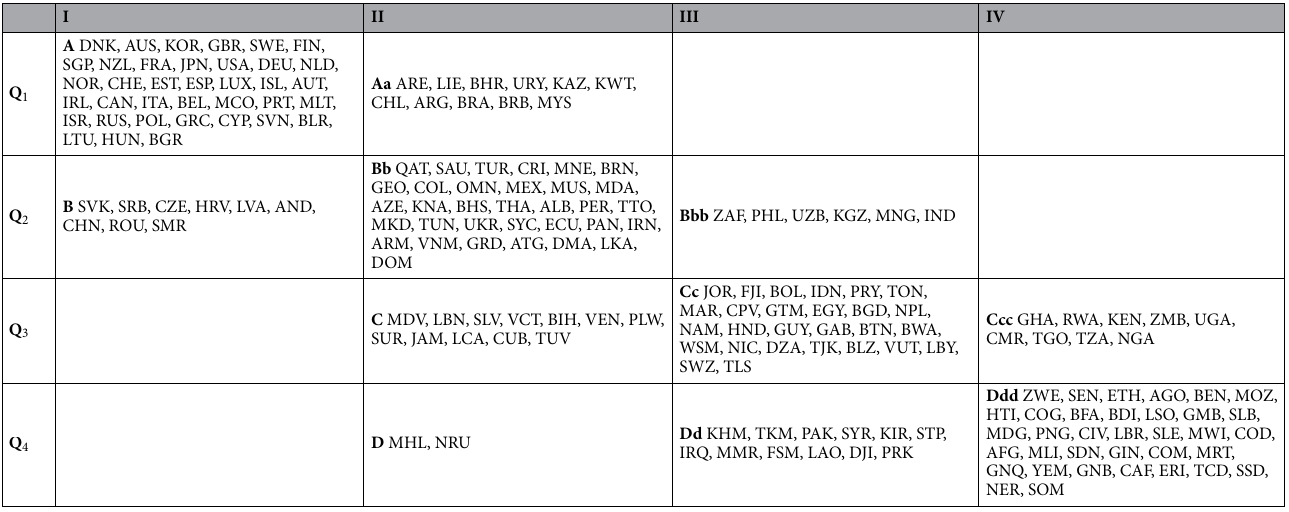
Table 2. Classification of countries based on the quartiles ( Q 1 , Q 2 , Q 3 , Q 4 ) of the overall EGDI distribution and on the development community